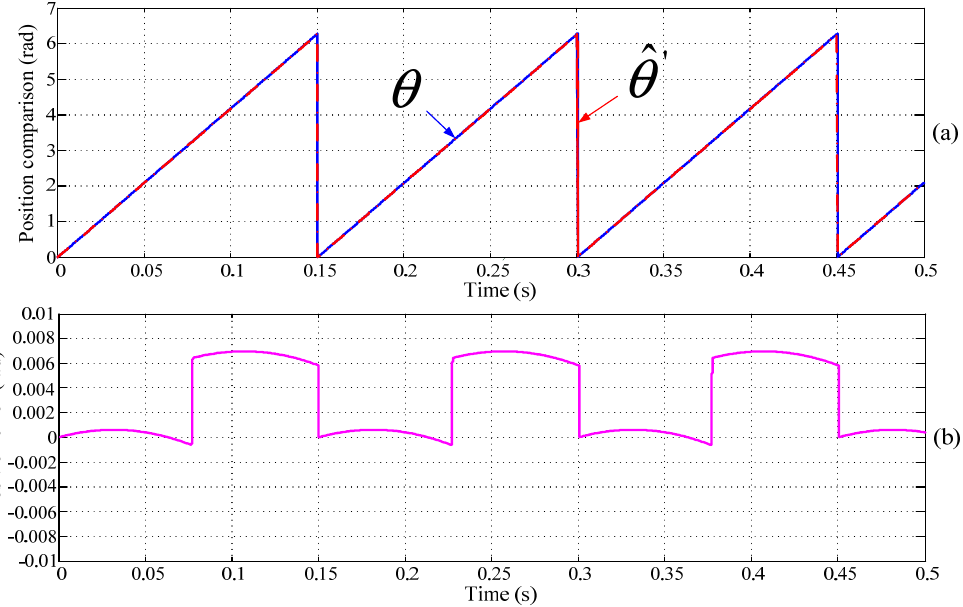
θ θ ) and rotor angle ) and rotor angle